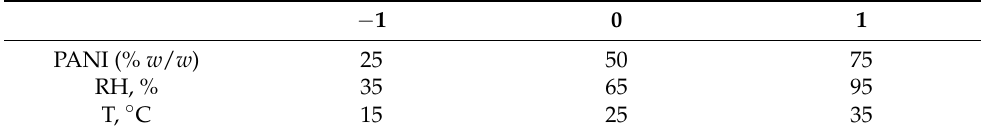
Table 8. Numerically encoded conditions of the experiment.